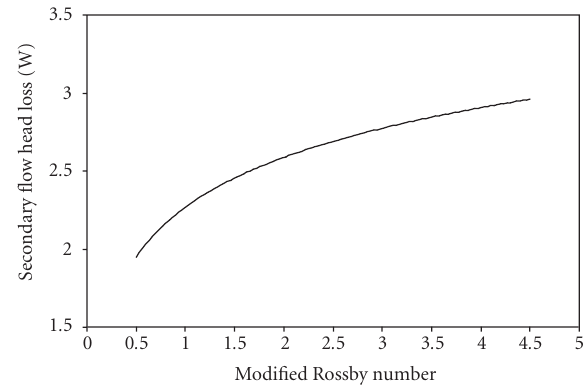
Figure 5: Pump head losses as a function of modified Rossby num-